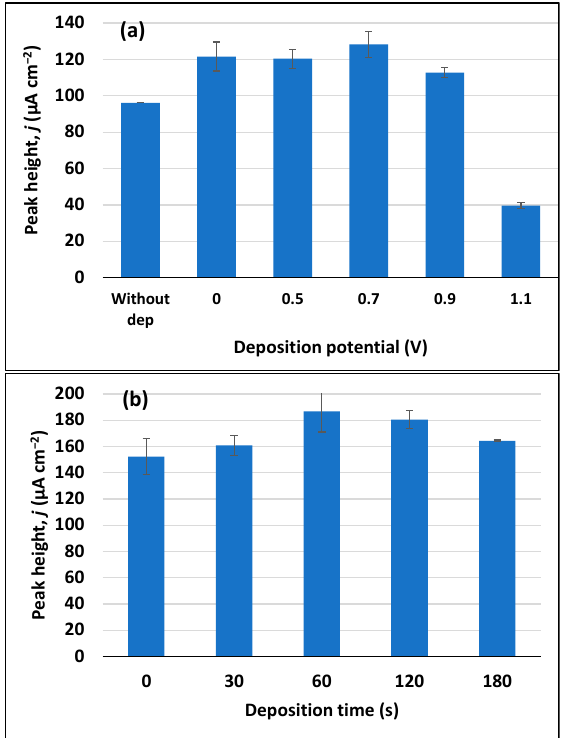
Figure 7. Optimization of deposition conditions for 10 µM trimethoprim in 0.1 M Britton–Robinson buffer pH 7. ( a ) Influence of deposition potentials on trimethoprim peak height (deposition time of 60 s). ( b ) Influence of deposition time on trimethoprim peak height.